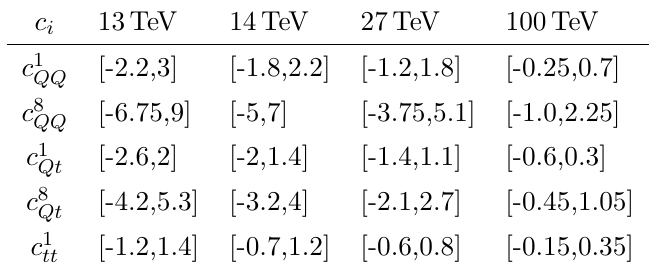
Table 3 . Theoretical individual limits on the 4-heavy operators’ coefficients for 13, 14, 27, and 100 TeV hadron colliders at the 95%CL level. Predictions are obtained including both linear and quadratic contributions in SMEFT with Λ = 1